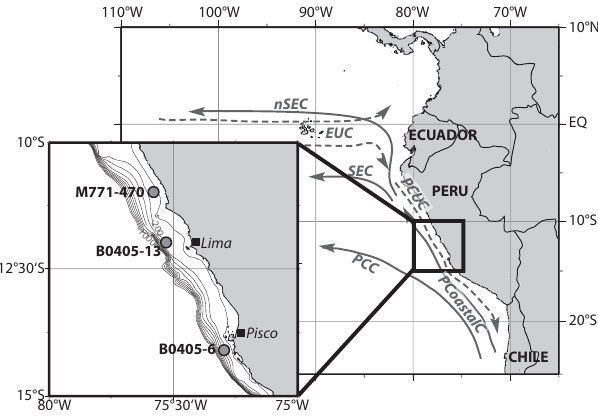
Figure 1. Schematic circulation patterns in the eastern equatorial Pacific. Surface currents (solid lines): (n)SEC, (northern) South Equatorial Current; PCC, Peru–Chile Current; PCoastalC, Peru Coastal Current. Subsurface currents (dashed lines): EUC, Equa- torial Undercurrent; PCUC, Peru–Chile Undercurrent (after Brink, 1983; Kessler, 2006). The inset shows the location of cores M771- 470, B0405-6 and B0405-13 (grey dots) in greater detail. The bathymetry is given for 0 to 1000m water depth in 100m incre-